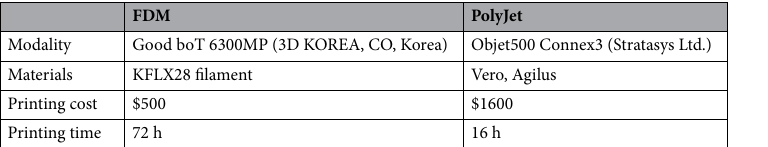
Table 2. Comparison of FDM and PolyJet phantoms. FDM fused deposition